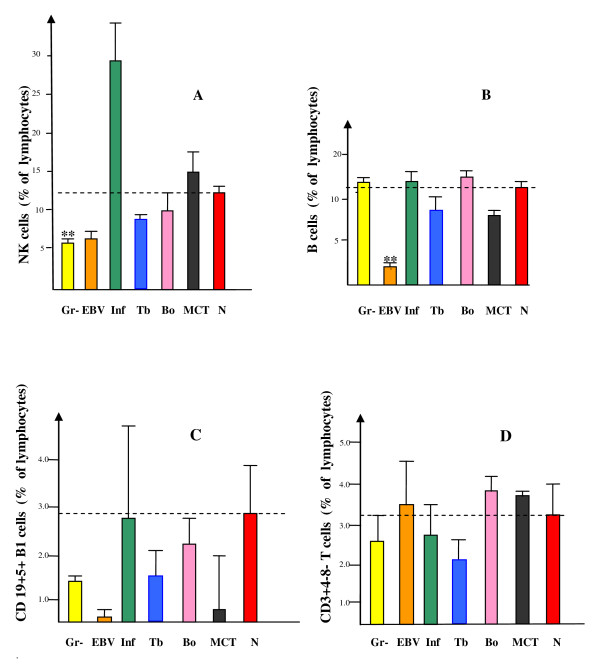
NK cells, B cells and mucosal subtypes of B and T cells. The results show the fraction among all blood lymphocytes of (A), NK cells; (B), B cells; (C), CD5+ B1 subtype of B cells; (D), gamma/delta TCR+ subtype of T cells as determined by a CD3+ CD4- CD8- phenotype. The dashed lines indicate the level of the normal controls. ** p < 0.01.